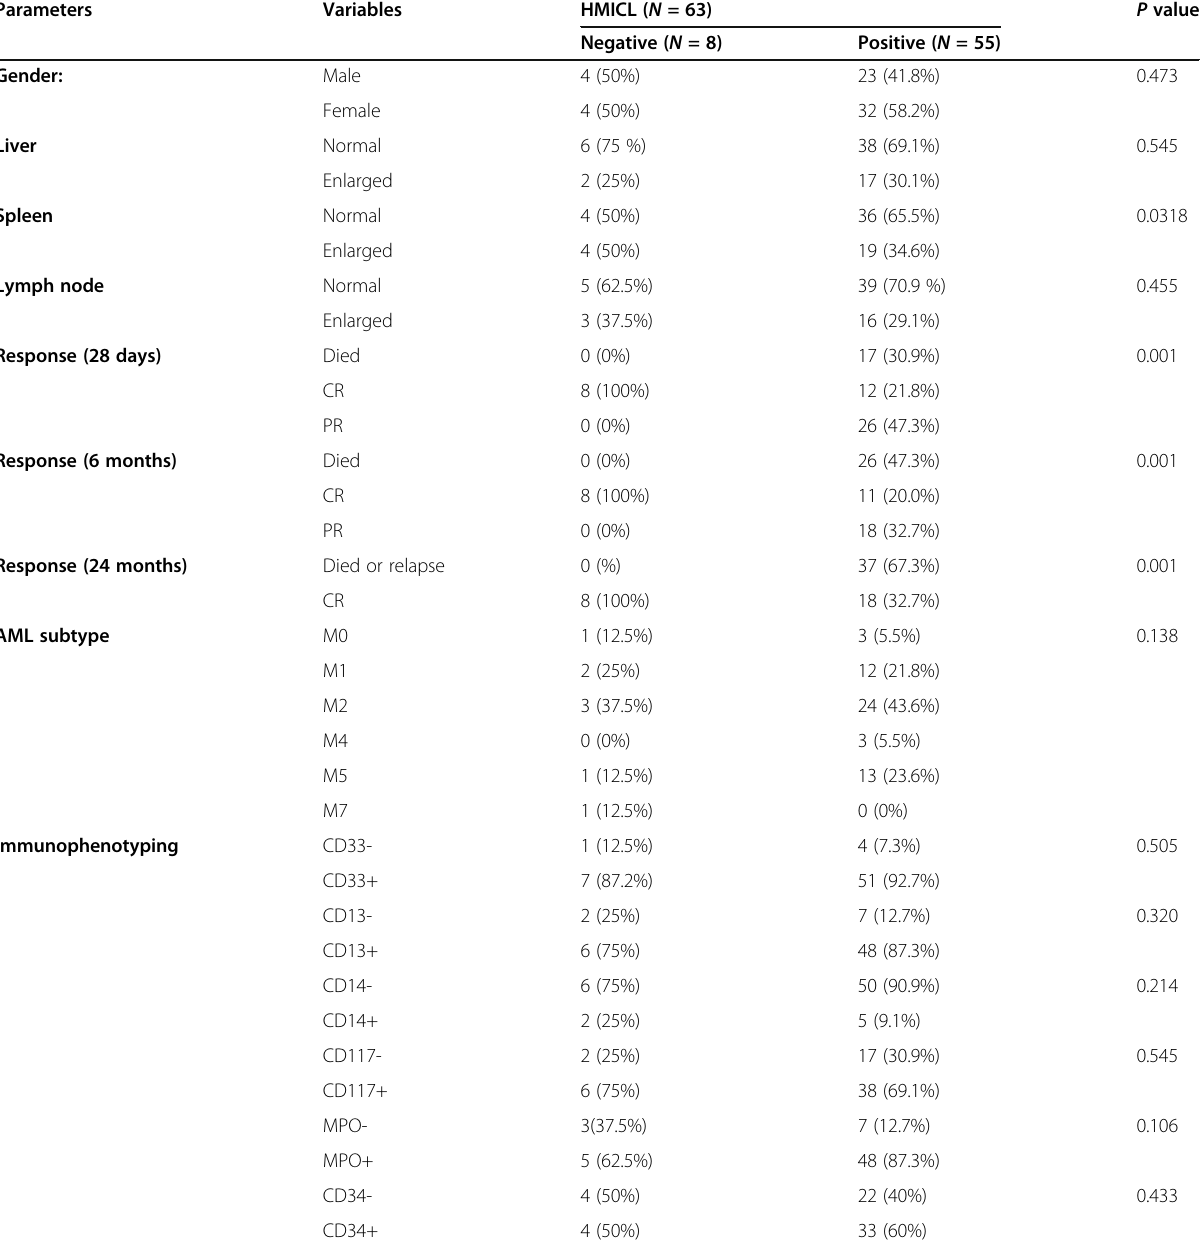
Table 5 Comparison between hMICL expression and AML patients ’ data Parameters